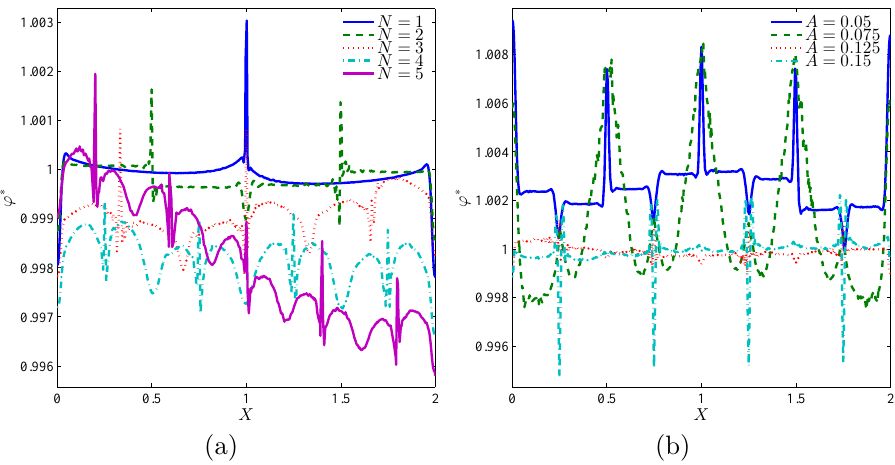
Figure 9. Variations of local normalized solid volume fraction interfaces with the horizontal line ( Y = 0.1) for different ( a ) N and ( b ) A at Ra = 10 6 and φ = 0.02.